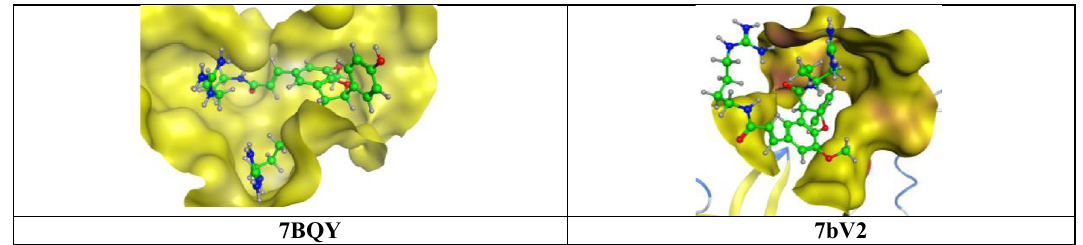
Fig. 5 High-resolution crystal structures of compound 24 in the active pockets (PDB ID: 7BQY and 7bV2)